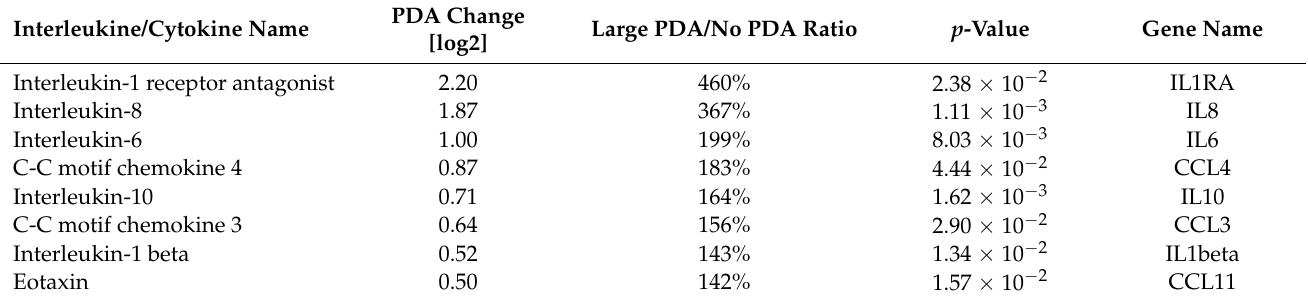
Table 3. Large PDA significant proteins from immunoassay. Statistically significant cytokines ( p -value < 0.05) differentiating large PDA from no PDA, as determined by